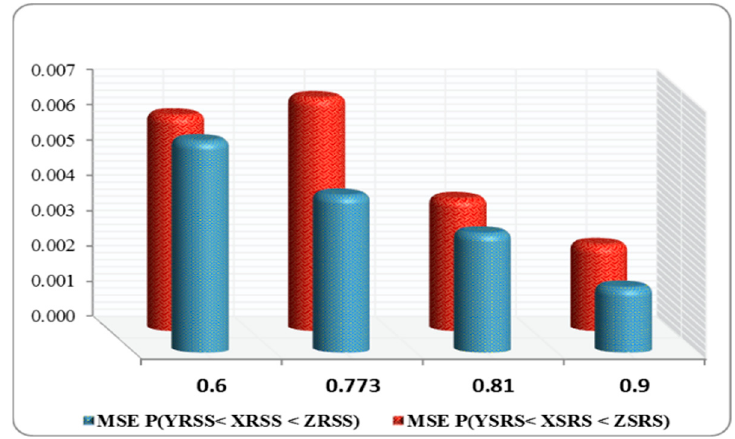
(cid:0) (cid:1) = ( ˆ R n ∗ , n ∗ , n ∗ 10,10,10 ) at different values of R . 2 for 2 3 1